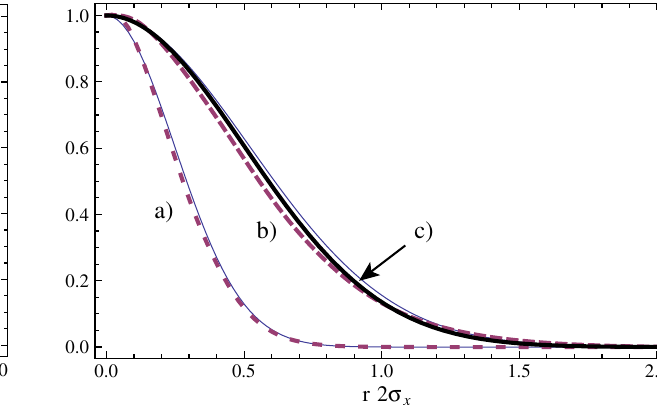
FIG. 8. Comparisonof the transverse normalized intensity mode profilebetween simulation andtheory for twocases:(a)a quasi-1D ¼ 0 : 04 , (cid:5) ¼ 0 , (cid:1) (cid:2) ¼ 0 : 23 where the mode scenario with (cid:5) d (cid:3) p profile is contained within the e-beam, and (b) a 3D scenario with ¼ 0 : 97 , (cid:5) ¼ 0 , (cid:1) (cid:2) ¼ 0 : 28 where the edges of the mode (cid:5) d (cid:3) p profile lie outside the e-beam. GENESIS results are represented as dashed lines while the solid, blue lines represent results from theory for both cases. The e-beam is shown in black